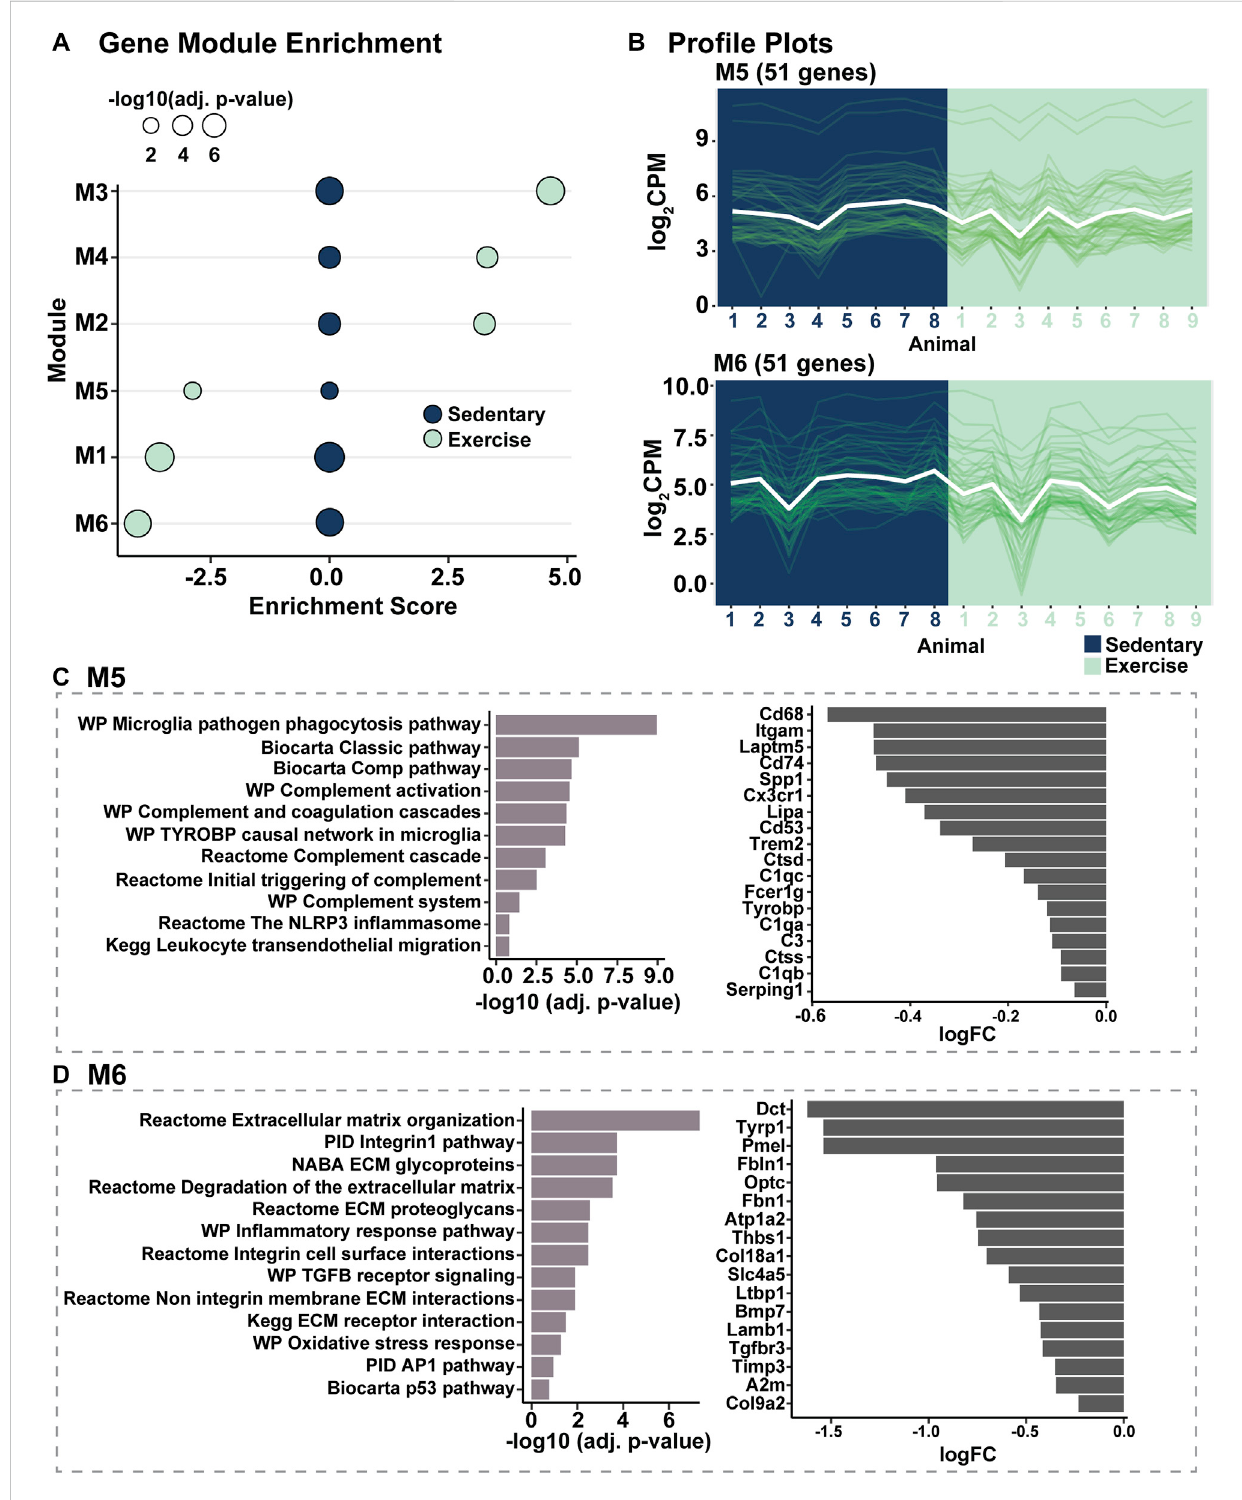
FIGURE 5 Modular gene co-expression analysis identi fi es in fl ammatory and extracellular matrix integrity pathway modulation in response to voluntary exercise. (A) Gene module enrichment identi fi ed six modules (M) which were signi fi cantly enriched (M2-M4, positively enriched, M1, M5 and M6, decreased enrichment) compared to sedentary controls. (B) Pro fi le plots of genes within modules M5 and M6 to show representative similar gene expression trends within modules. (C,D) Pathway analyses showing in fl ammatory and extracellular matrix integrity pathways were associated with genes in M5 and M6